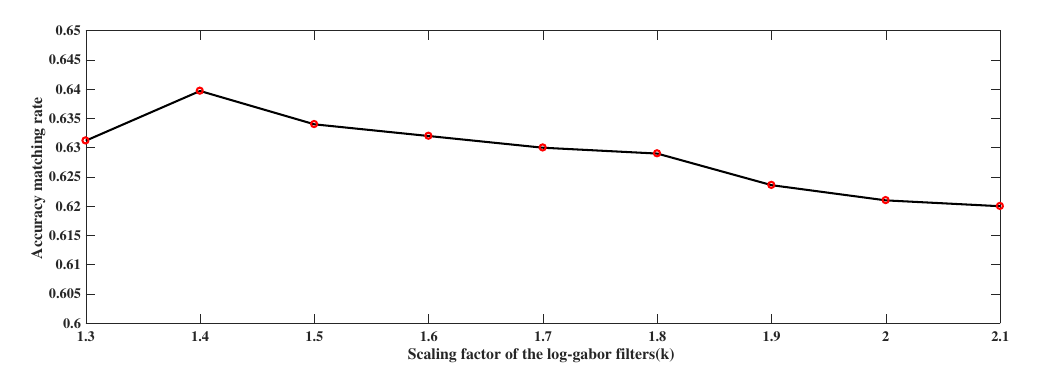
Figure 2. Illustration of corner detection.